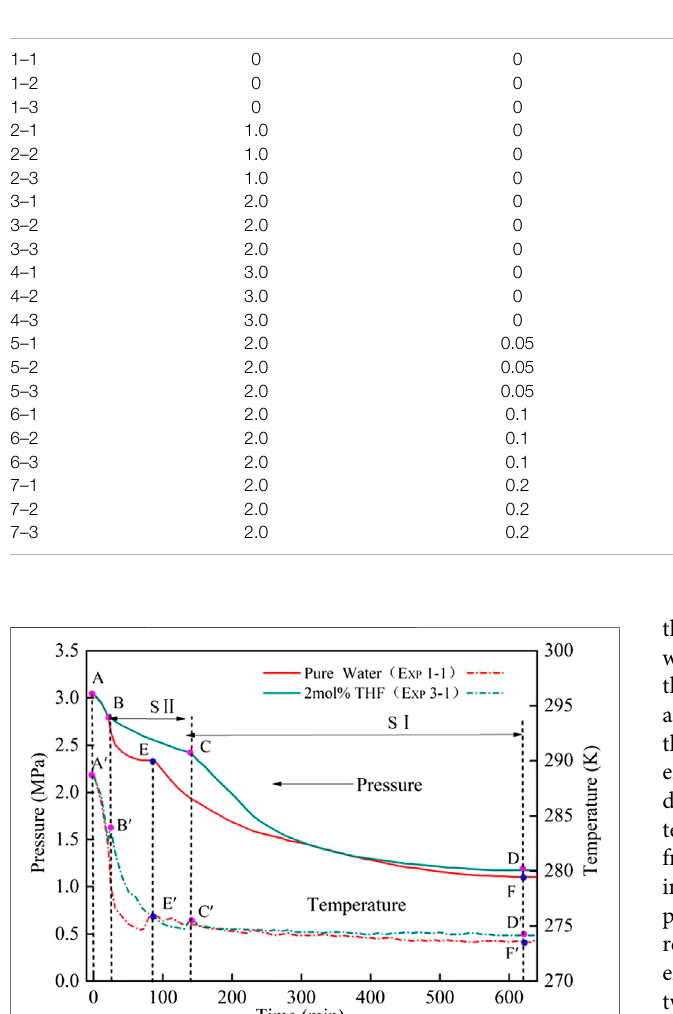
Frontiers in Energy Research |